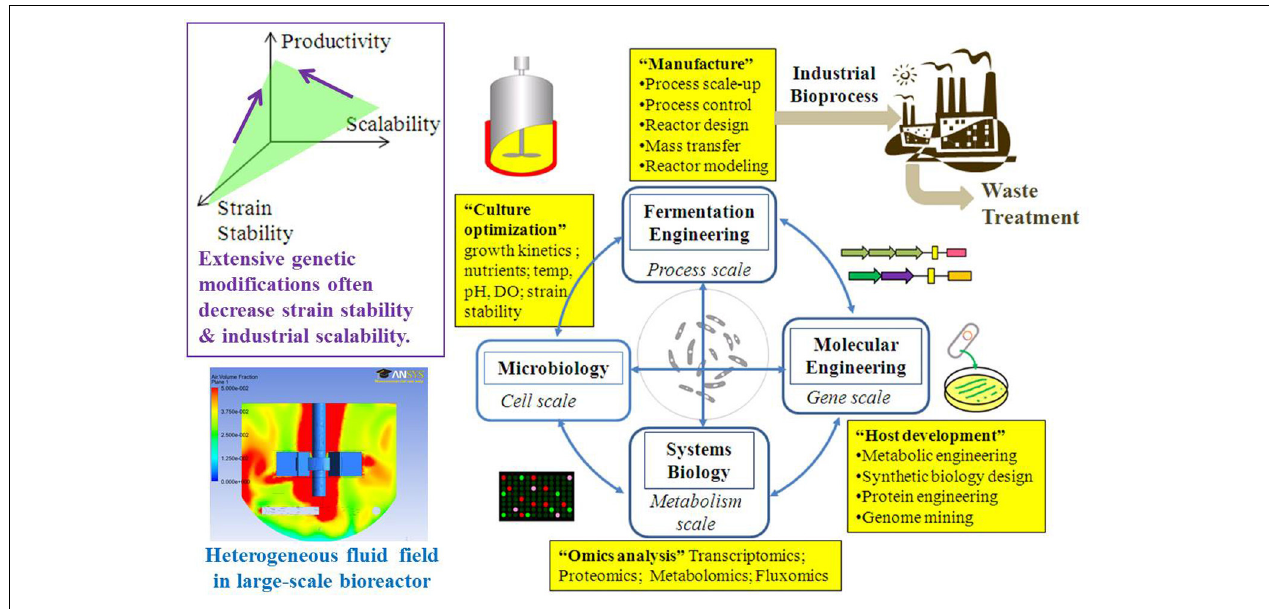
FIGURE 2 | The design-engineering-analysis cycle for scale-up of biofuel fermentation.